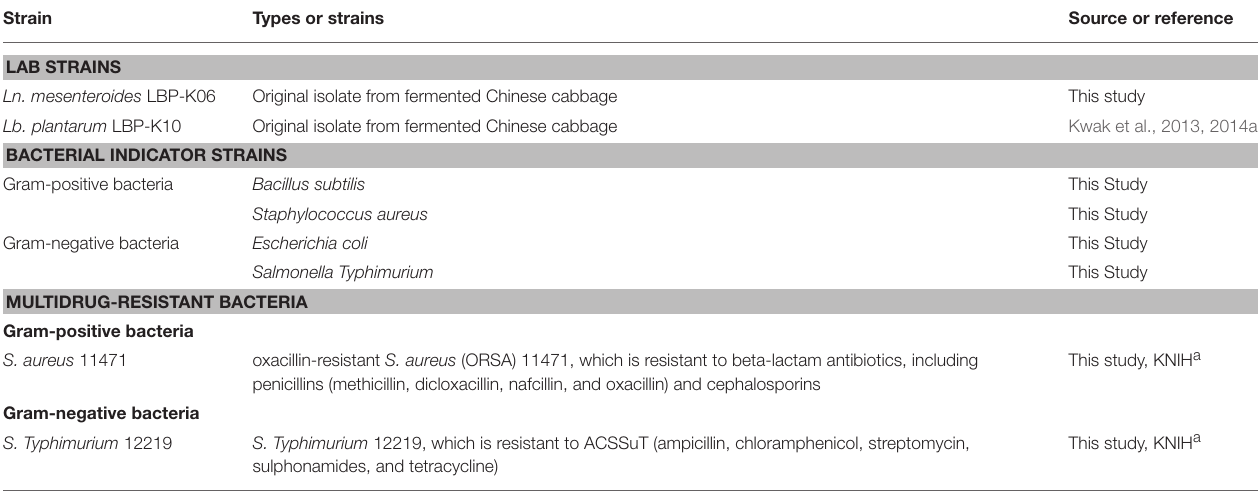
TABLE 1 | LAB strains isolated from three types of Korean traditional fermented vegetables and Gram-positive, Gram-negative, and multidrug-resistant bacteria used in this